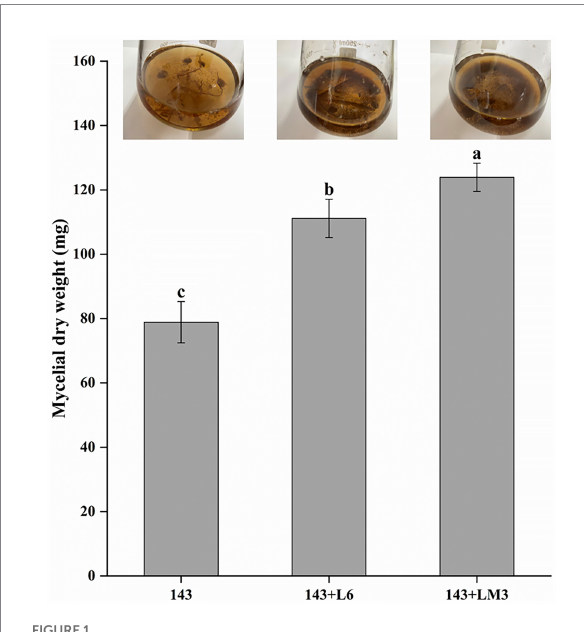
FIGURE 1 Effects of the fermented product of L6 or LM3 on Oidiodendron maius 143 growth. Mycelial dry weight of 143 in YPD liquid media supplemented with the fermentation broth of L6 or the fermentation broth of LM3. 143 is O. maius 143; 143 + L6 is the co-inoculation of the O. maius 143 and L6 isolates; and 143 + LM3 is the co-inoculation of the O. maius 143 and LM3 isolates. The treatments labeled with different letters are significantly different according to Tukey’s HSD at p < 0.05. Bars represent the standard deviations of the means.